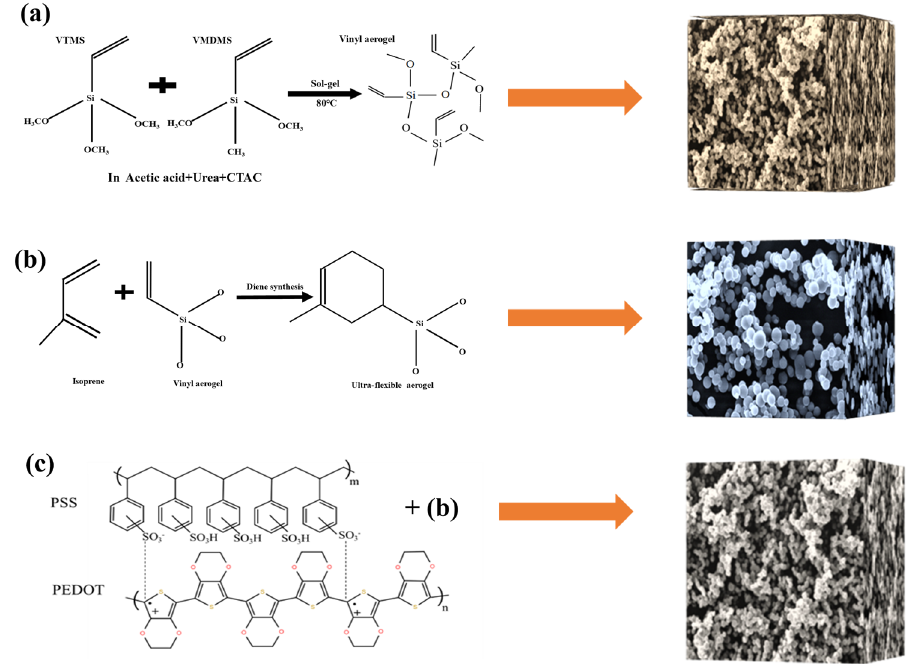
Figure 9. ( a ) Synthesis of the vinyl aerogel; ( b ) synthesis of the ultra-flexible aerogel; ( c ) preparation of conductive silica aerogel by compounding PEDOT:PSS.